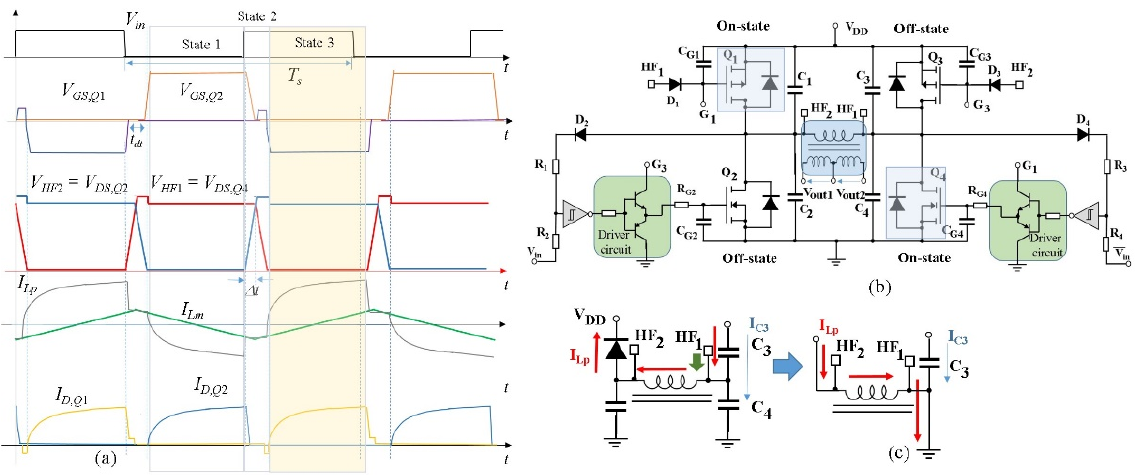
Figure 9. ( a ) Qualitative switching waveforms description at third phase of the operative condition (State 3). ( b ) Switching conditions of the MOSFETs. ( c ) Primary side of the HF transformer and capacitors’